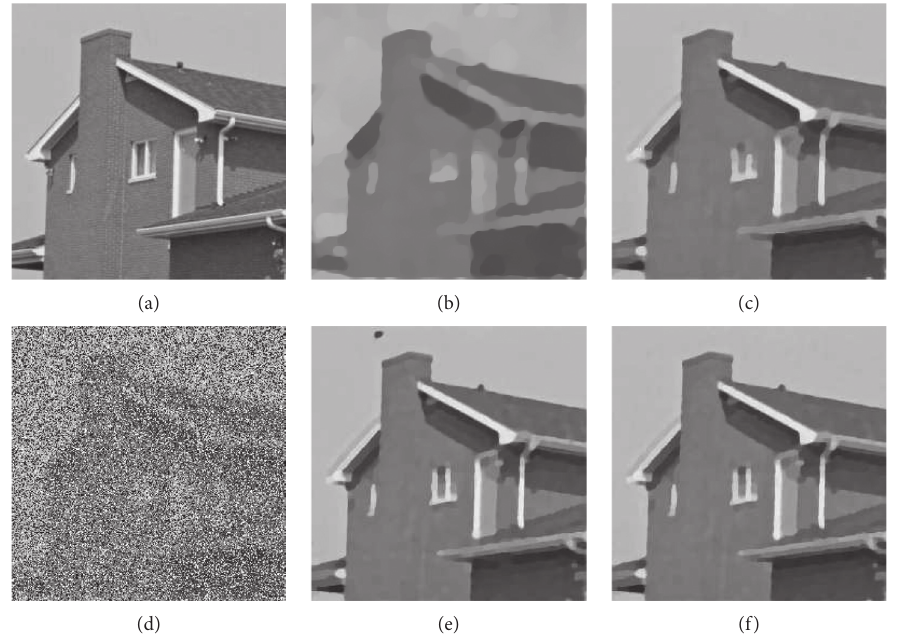
Figure 13: The recovery results (House 256) by Average blur with 70% RV noise. (a) Original. (b) TVL1, PSNR � 20.6806. (c) TVSCAD, PSNR � 26.7422. (d) Average blur (lev � 0.7). (e) TVLog, PSNR � 27.9585. (f) LogTVSCAD, PSNR �